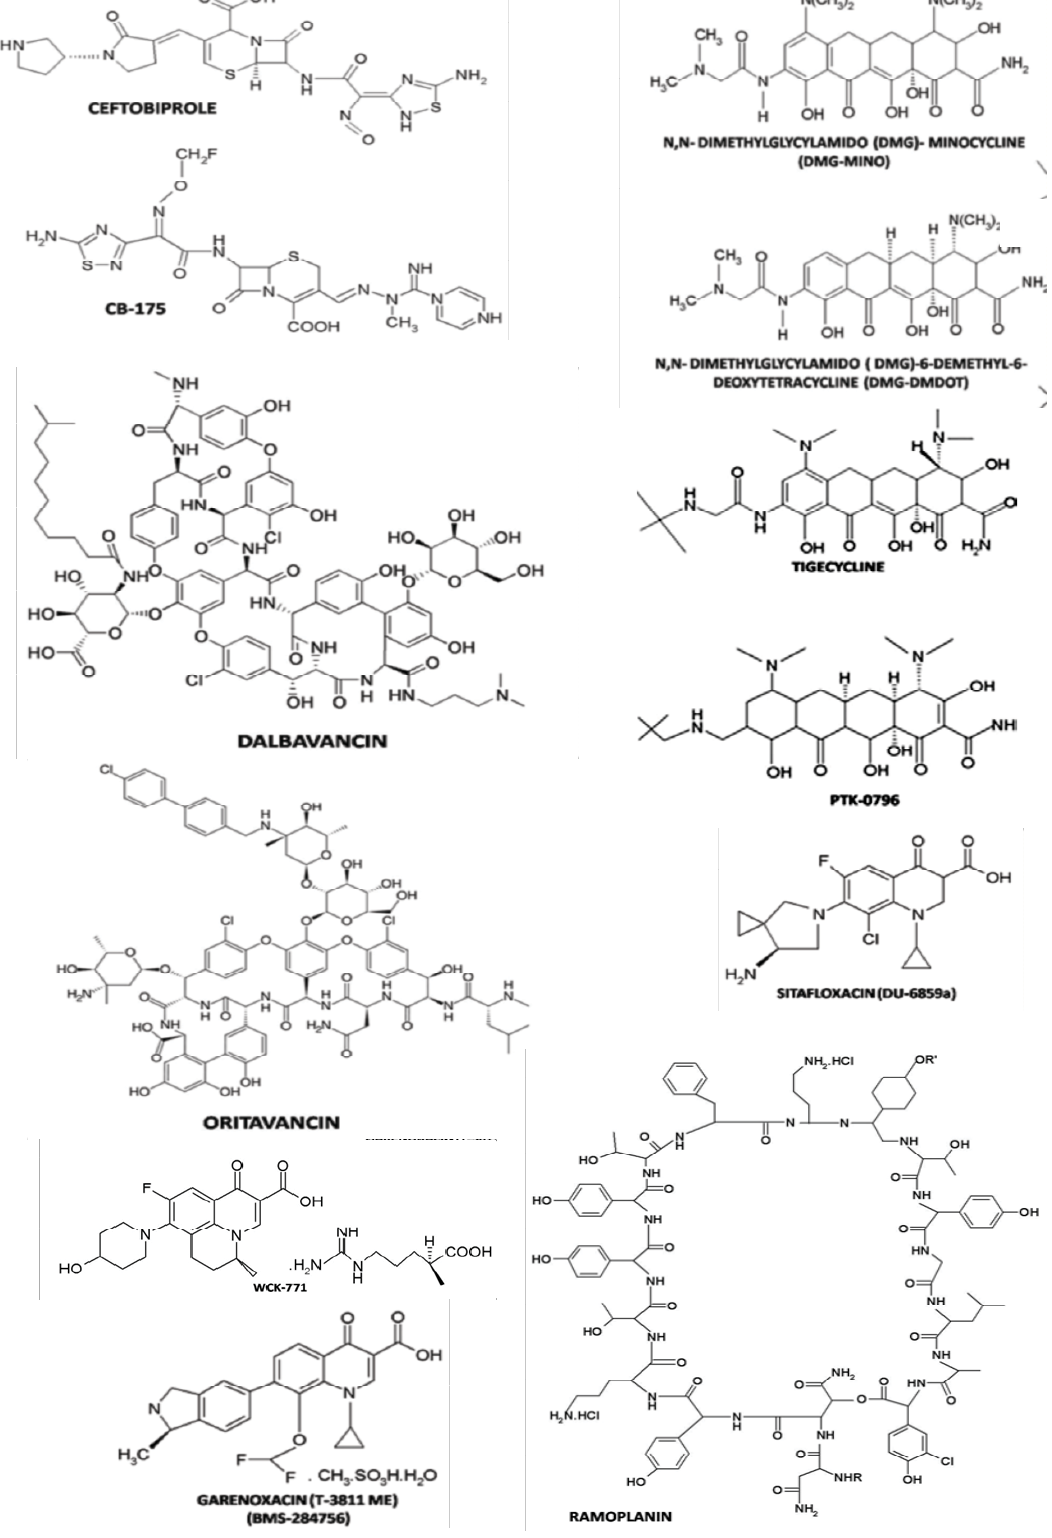
Figure 1. New extended class of antimicrobial drugs under different phases of clinical